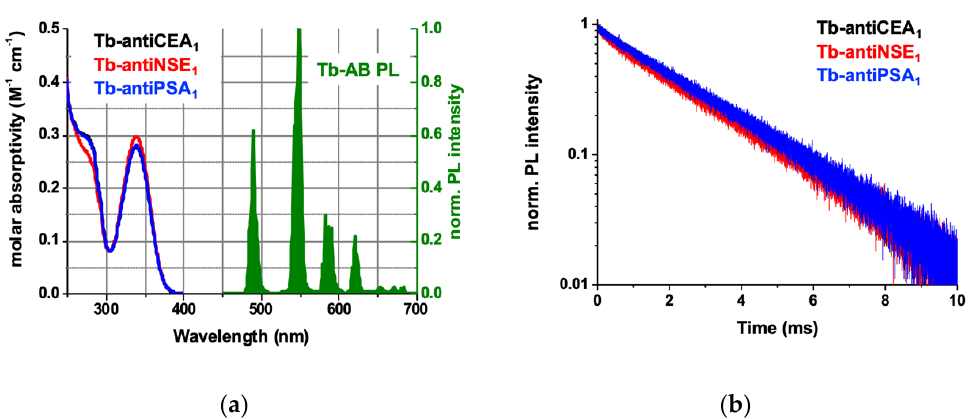
Figure 1. ( a ): Absorption (black, red, and blue lines) and photoluminescence (PL) (green, excitation wavelength: 365 nm) spectra of Lumi4 ‐ Tb–antibody (Tb–AB) conjugates. The Tb PL emission lines correspond to the 5 D 4 → 7 F 2 ‐ 0 (approximately 650–700 nm), 5 D 4 → 7 F 3 (approximately 620 nm), 5 D 4 → 7 F 4 (approximately 590 nm), 5 D 4 → 7 F 5 (approximately 550 nm), and 5 D 4 → 7 F 6 (approximately 490 nm) transitions. ( b ): Normalized Tb–AB conjugates PL decay curves upon pulsed excitation at 365 nm with a repetition rate of 100 Hz. Amplitude ‐ averaged decay time: τ (Tb) = 2.6 ± 0.1 ms. Please note that the black curves in ( a ) and ( b ) are almost identical to the blue curves and therefore, they are not very well visible behind the blue curves.